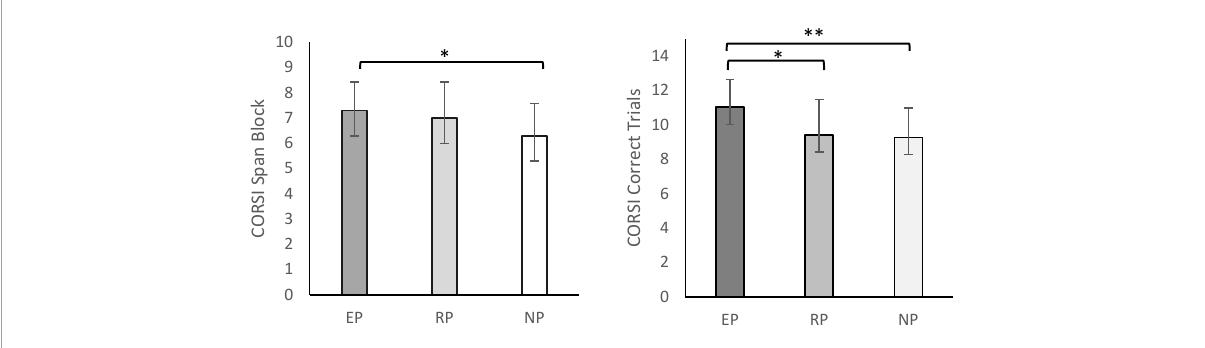
FIGURE2 CORSI span block and correct trials performance. Error bars represents standard deviation. ( EP, Experts Players Group; RP, Regular Players Group; NP, Non-videogame Players). ∗ p < 0.05, ∗∗ p < 0.005.